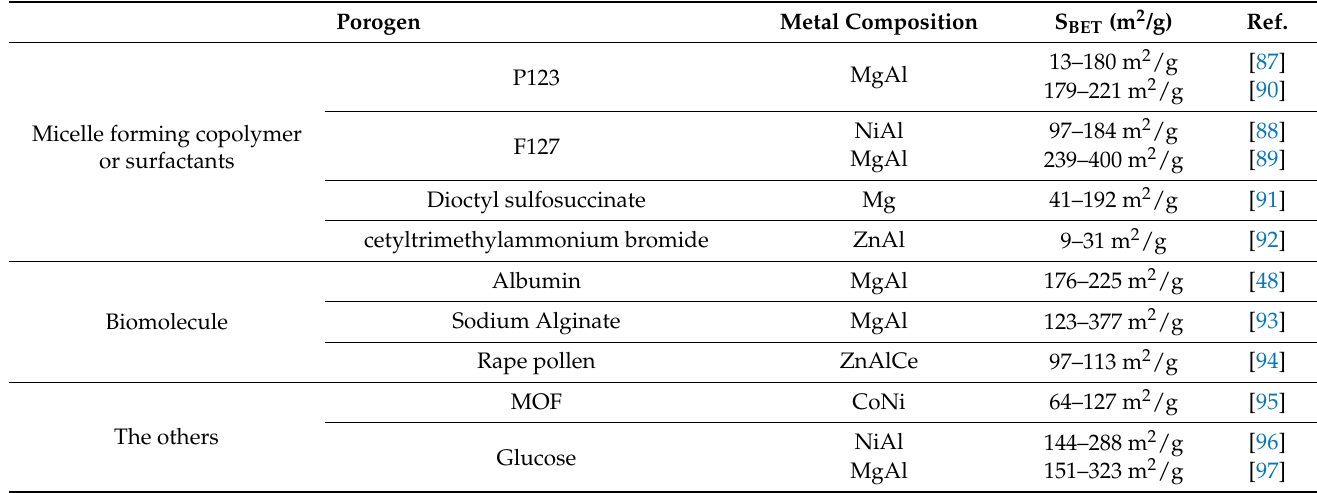
Table 2. Specific surface area values of MMOs depending on the types of